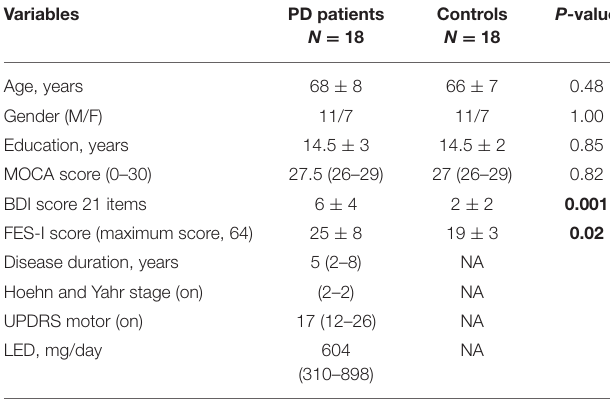
TABLE 1 | Demographic and clinical characteristics for all